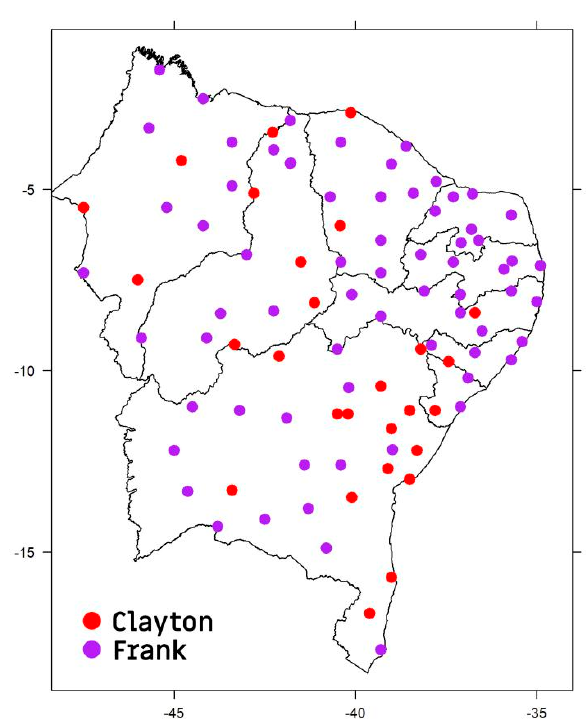
Figure 6. Copula classes chosen according to AIC criterion to extract joint distributions of Severity and Duration.